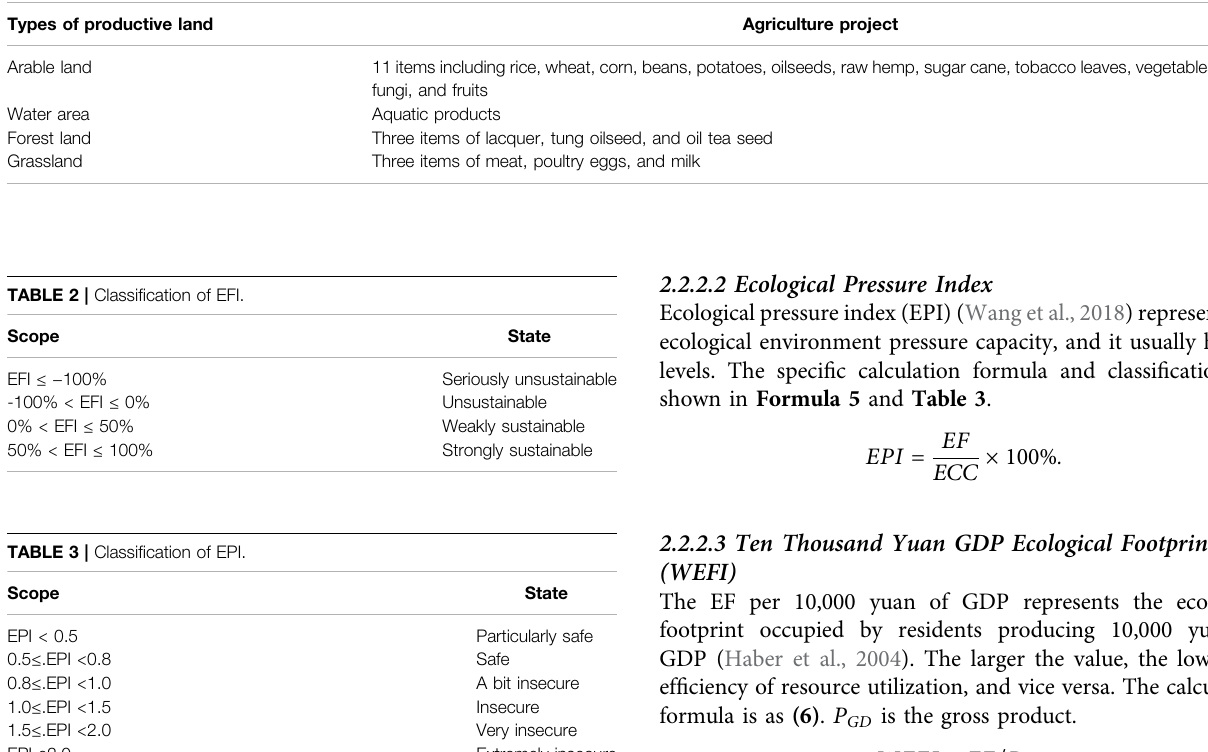
TABLE 1 | Classi fi cations of agricultural projects of four types of productive land.